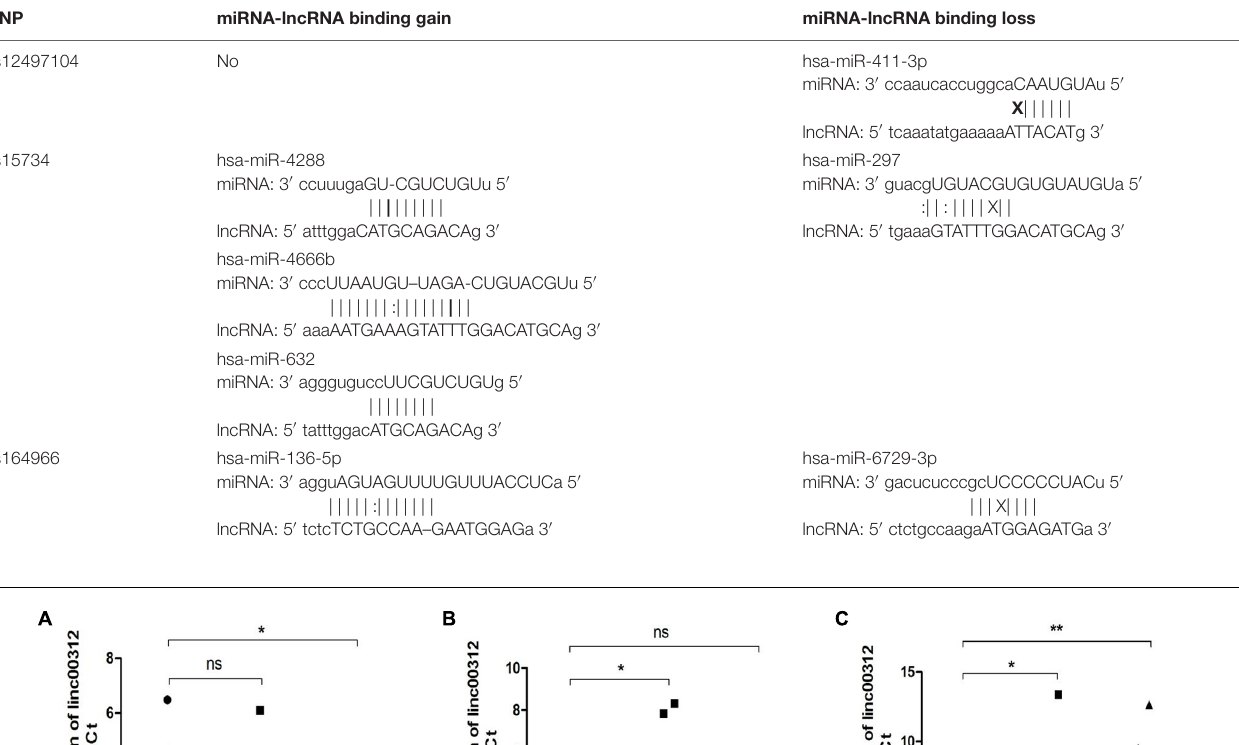
TABLE 3 | Prediction of candidate SNPs causing miRNA-lncRNA gain or loss by TargetScan and miRanda.